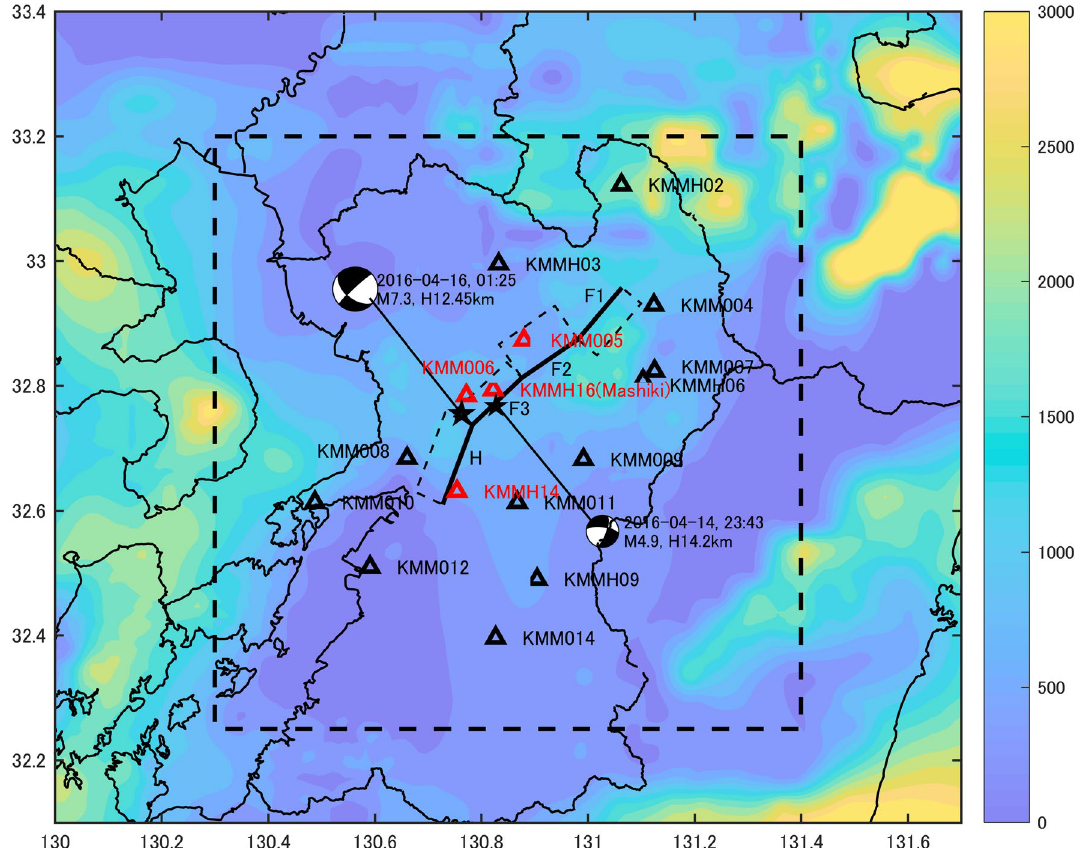
Fig. 1 Map of target area. Background is the depth of bottom interface of the Vs area of calculation, solid line—surface traces of the fault segments, triangles are K-NET and KiK-net sites within 50 km from fault (red—target sites for SMGA inversion, black—validation